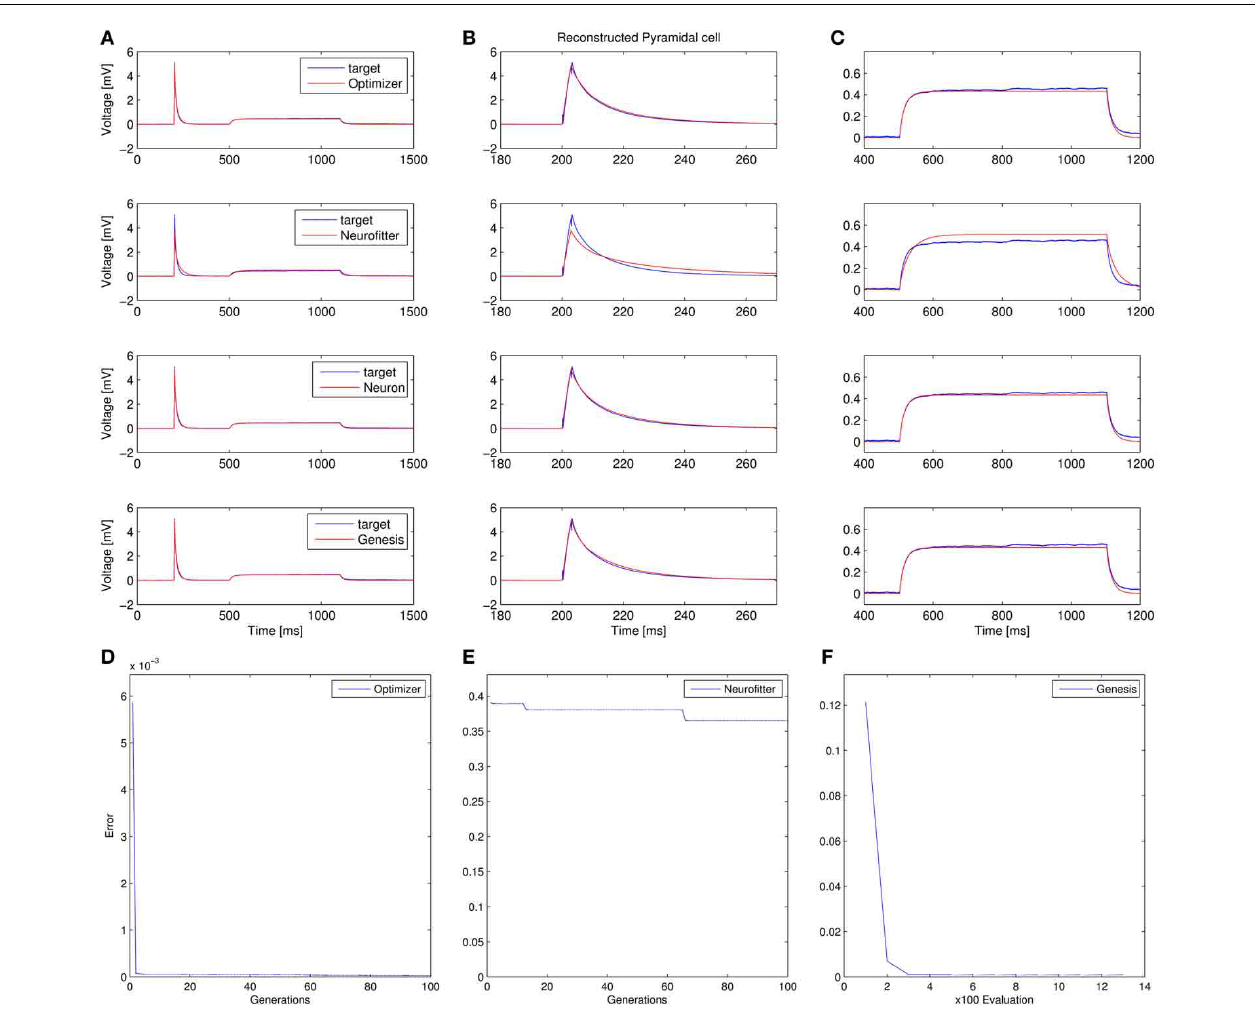
FIGURE 12 | Comparison of the performance of the four parameter optimization tools on Use case 4 (fitting the parameters of a morphologically detailed passive multi- compartmental model to experimental data). (A–C) Comparison of the best-fitting traces with the target trace. (A) Overview of the